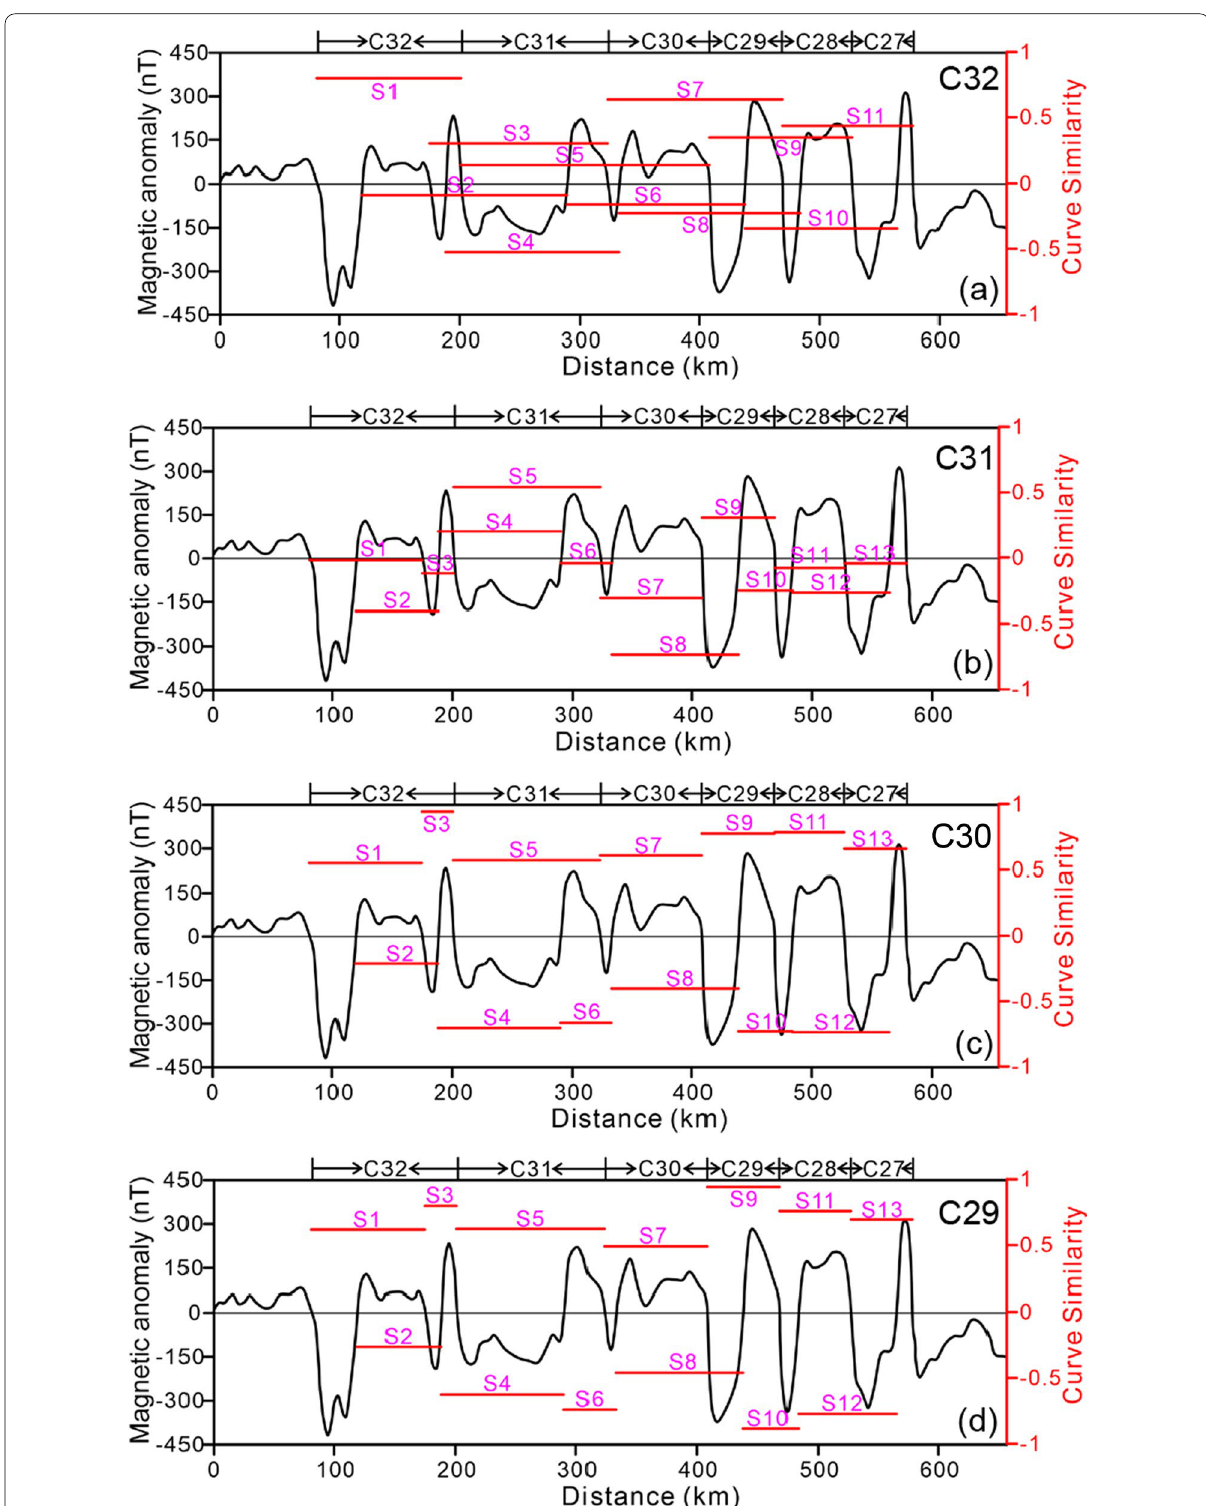
Fig. 15 The identification results of the polarity chron C32-27 of the marine magnetic profile EL33. a – f The identification results of the polarity chron C32, C31, C30, C29, C28 and C27, respectively. g The identification results of the polarity chron C30-31. h The identification results of the polarity chron C27-29. The red lines represent the values of the curve similarity in different steps (Magenta